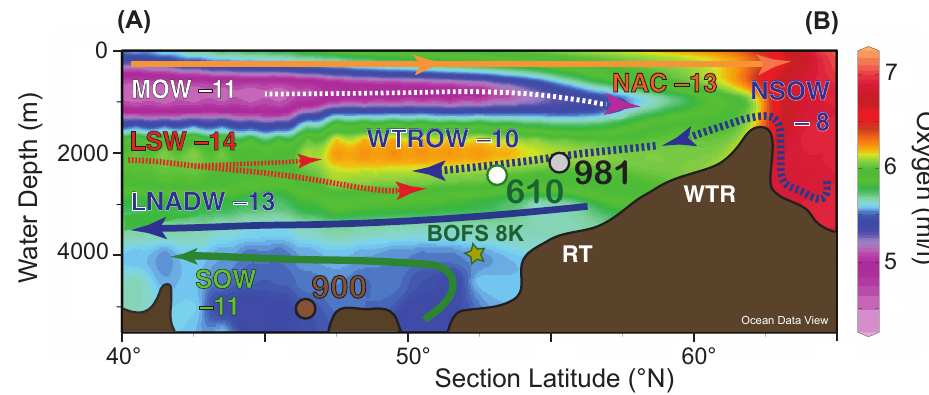
Figure 2. Modern water mass distribution based on oxygenation (mLL − 1 ; data from world ocean database using ocean data view software; Schlitzer, 2013) and associated ε Nd signature in the northeast Atlantic from actual water column measurements (Lacan and Jeandel, 2004a, b, 2005; Rickli et al., 2009), near-core top leachates, and foraminifera (Crocket et al., 2011; Piotrowski et al., 2013; this study). WTR – Wyville Thomson Ridge, RT – Rockall Trough, NAC – North Atlantic Current, NSOW – Nordic Seas overflow water, LSW – Labrador Sea Water, MOW – Mediterranean outflow water, WTROW – Wyville Thomson Ridge overflow water, NADW – North Atlantic deep water, and SOW – Southern Ocean